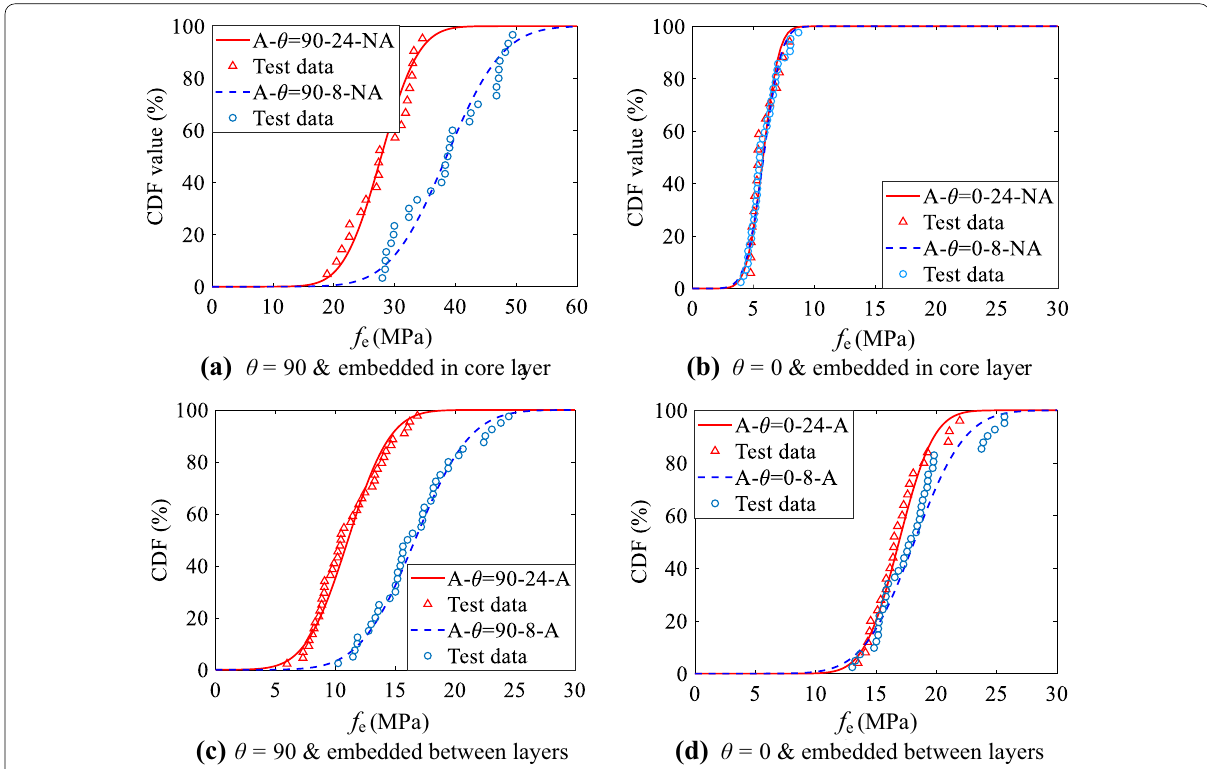
Fig. 11 Embedment strength of dowels with different diameters (group